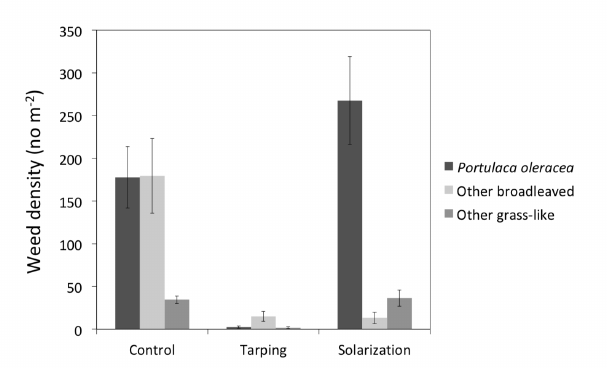
Figure 3. Mean ± SEM density of Portulaca oleracea , other broadleaved weeds, and other grass-like weeds measured at 14 days after plastic termination in the 2017 TARP exper- iment. Data are shown pooled across treatment